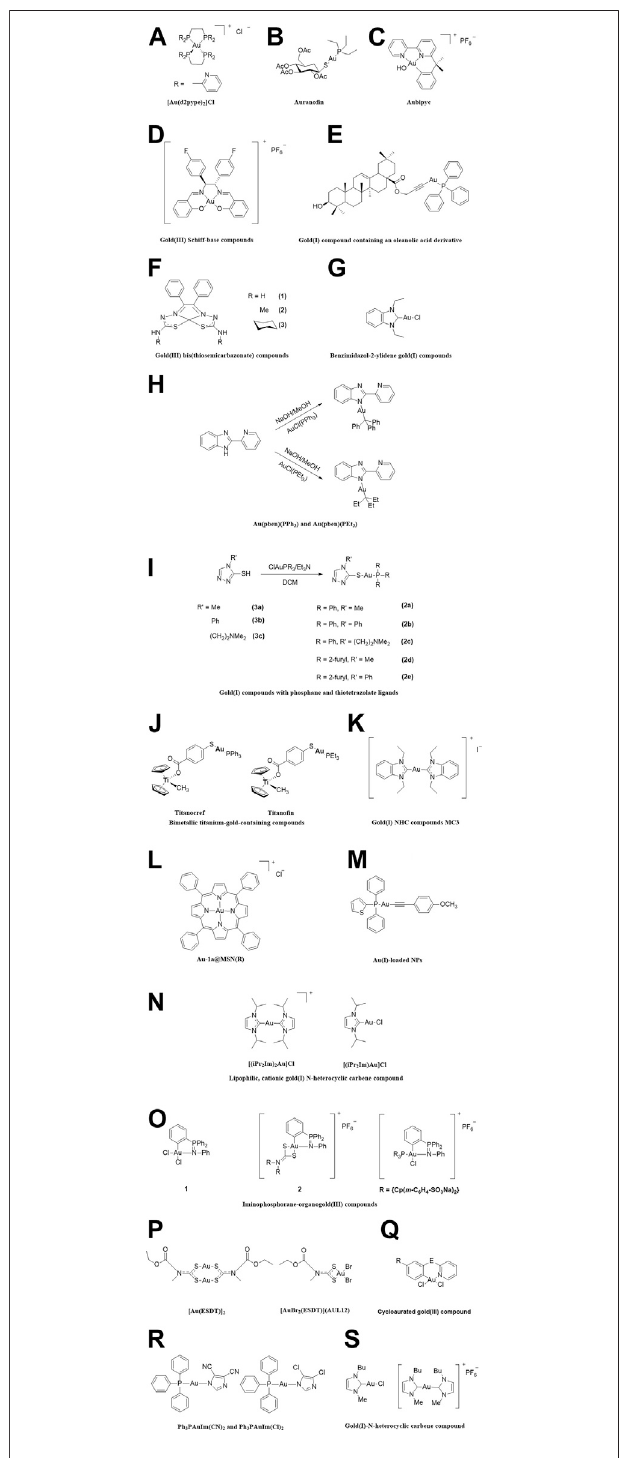
FIGURE1| Thechemicalstructureofthegoldcompoundsmentionedin the paper. (A) [Au(d2pype) 2 ]Cl; (B) Aurano fi n; (C) Aubipyc; (D) Gold(III) Schiff- base compounds; (E) Gold(I) compound containing an oleanolic acid derivative; (F) Gold(III) bis(thiosemicarbazonate) compounds; (G) Benzimidazol-2-ylidene gold(I) compounds; (H) Au(pben)(PPh 3 ) and Au(pben)(PEt 3 ); (I) Gold(I) compounds with phosphane and thiotetrazolate ligands; (J) Titanocref and Titano fi n; (K) Gold(I) NHC compounds MC3;